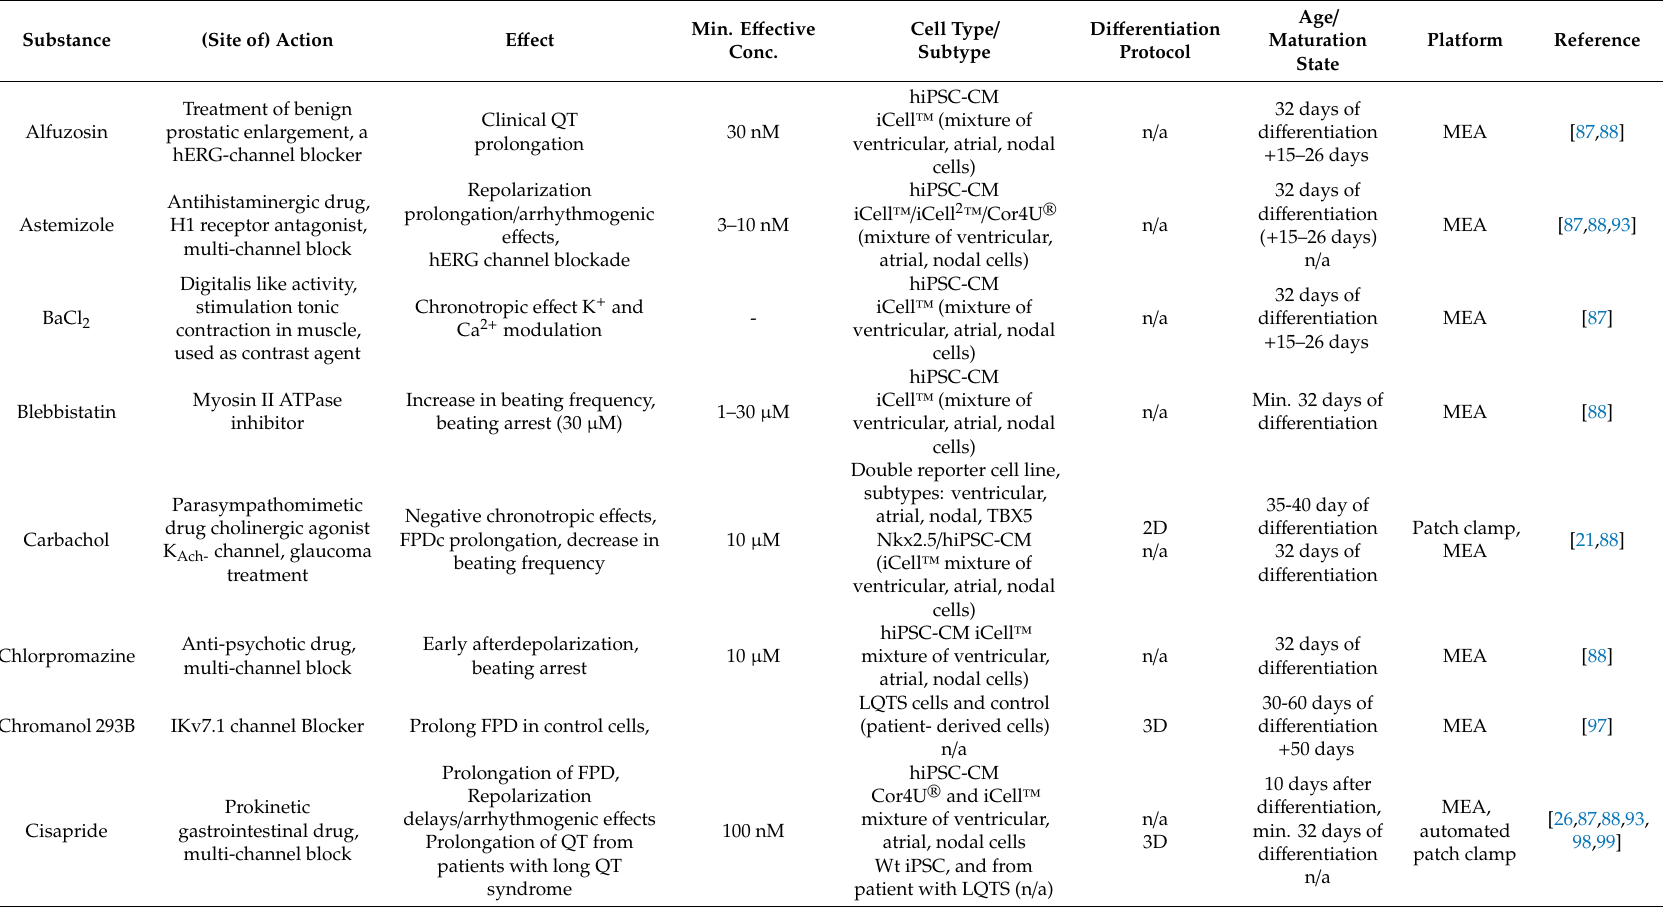
Table 3. MEA based safety testing of drugs without cardiac indication using human induced pluripotent stem cell cardiomyocyte (hiPSC-CM). Min. E ff ective E ff ect